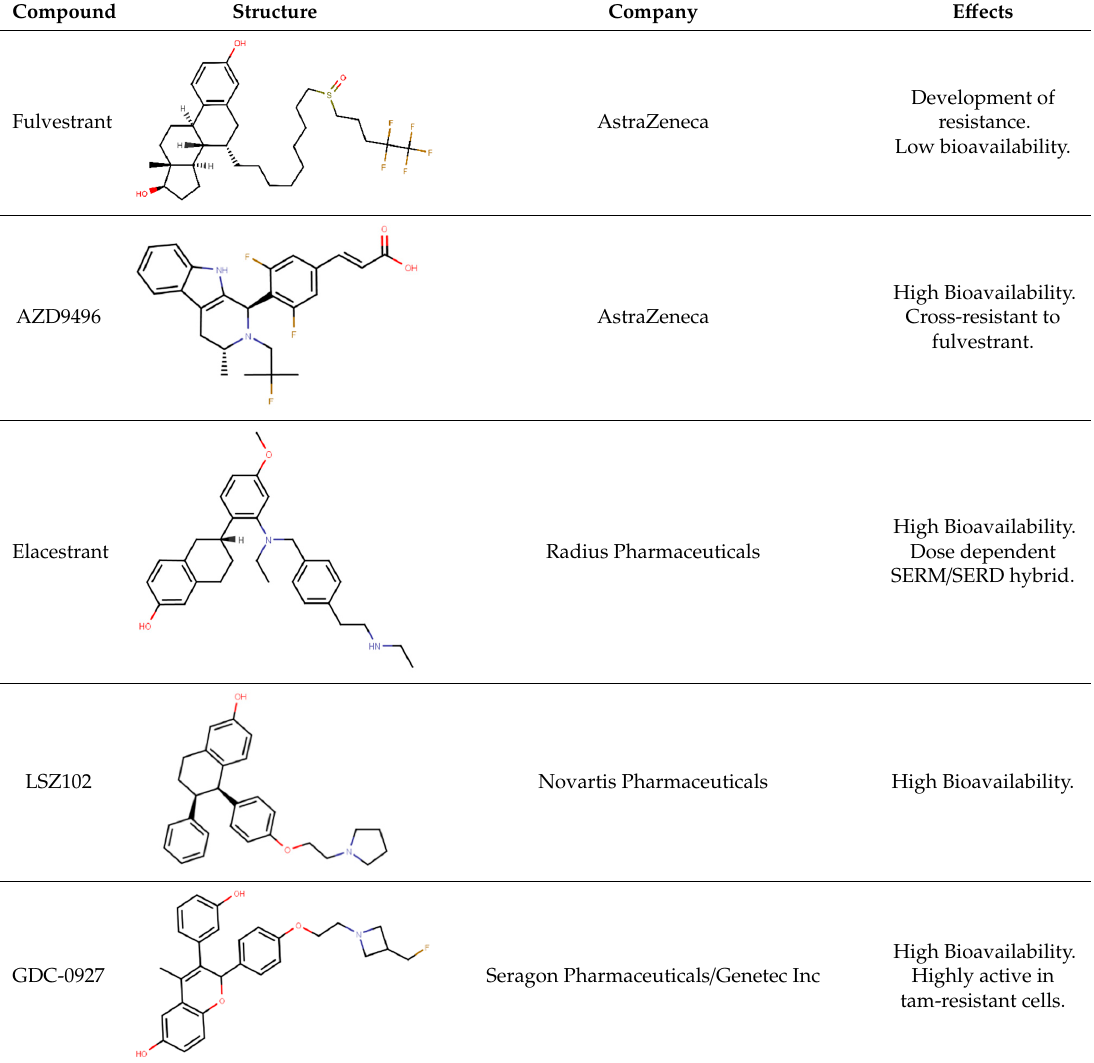
Table 3. List of notable selective estrogen receptor degraders.